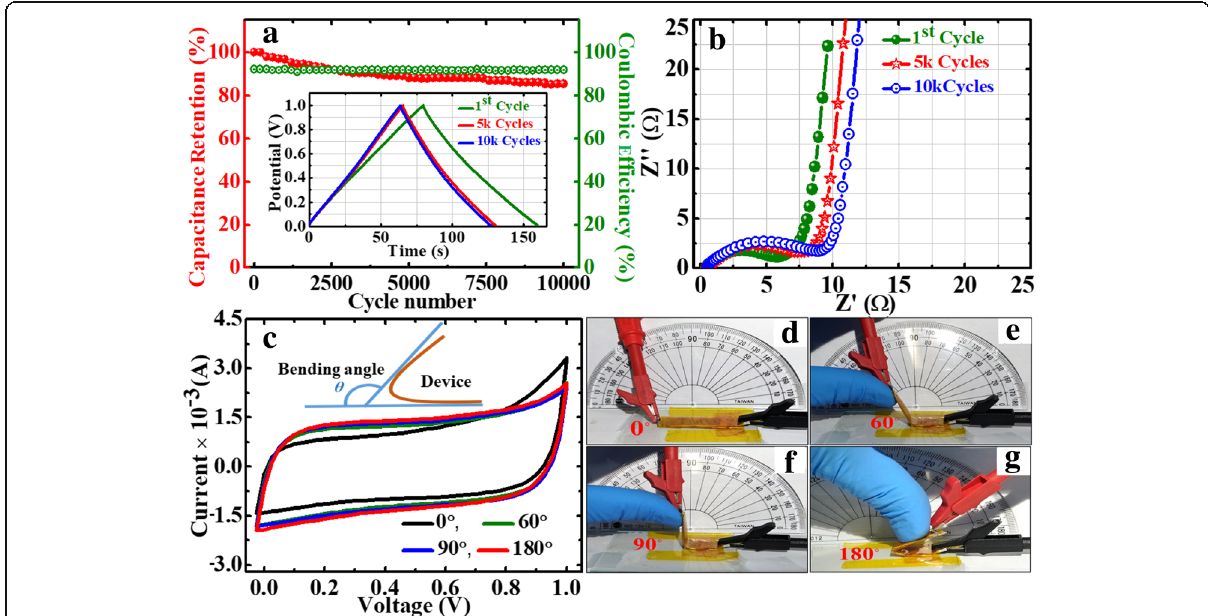
Fig. 13 The long cycle performance of GP10C/KOH/GP10C symmetrical coin cell. a Cyclic stability and columbic efficiency recorded at 0.3 Ag − 1 for 10,000 successive cycles, and inset shows the GCD profiles of 1st, 5000th and 10,000th GCD cycles. b Nyquist plots recorded just after 1st, 5000th and 10,000th cycles, and inset shows a red LED light up by single coin cell. c The CV curves at a scan rate of 20 mVs − 1 of symmetrical solid state flexible device using gel polymer electrolyte under different bending angles. Digital photographs of the device under different bending angles, d 0°, e 60°, f 90°,and g 180°,